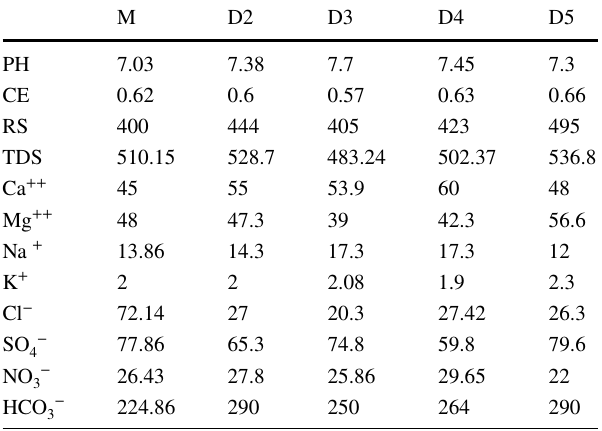
Fig. 3 Hydrogeological system chart of study area (Mebarki et al. 2021) Table 1 Physicochemical parameters of samples (Mebarki et